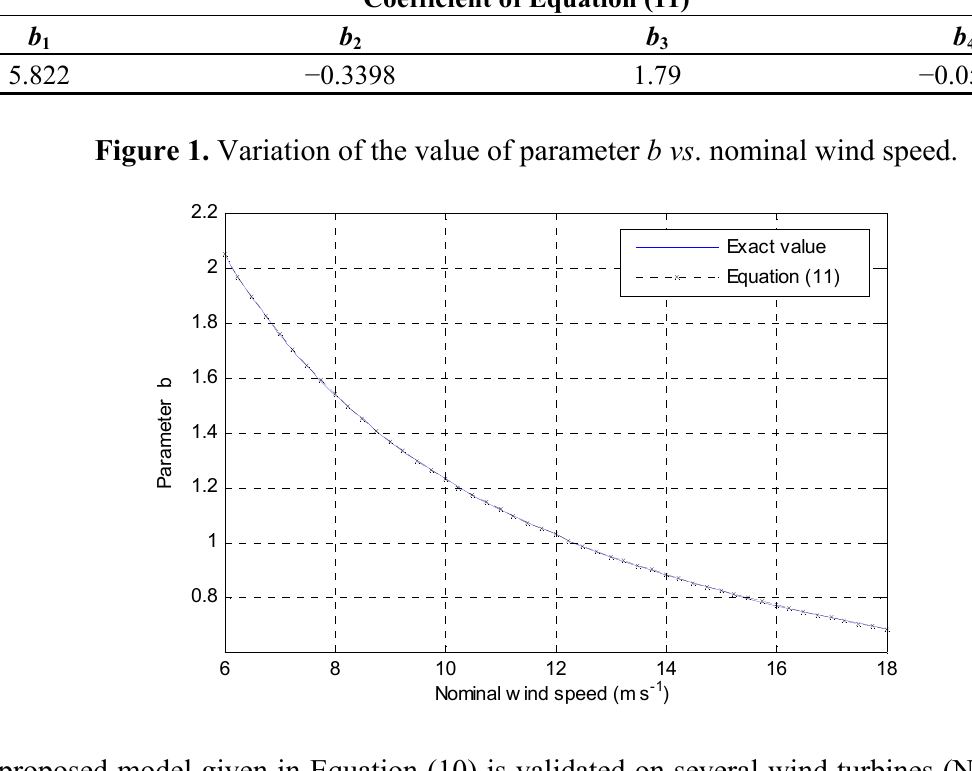
Table 1. The value of coefficients b